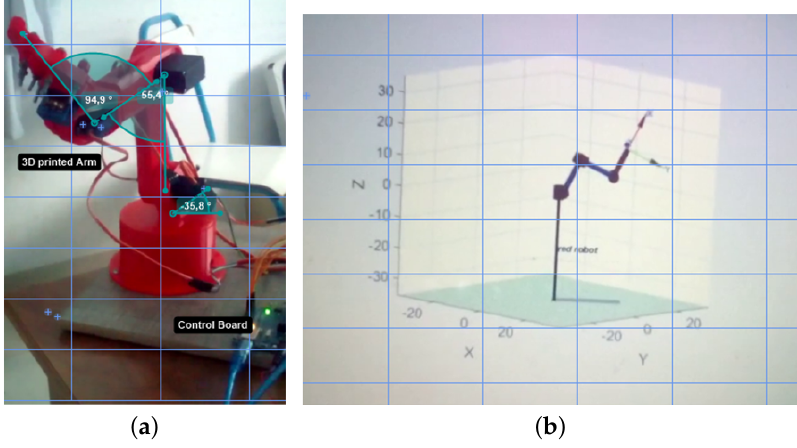
Figure 9. ( a ) 3D arm setup ( b ) Solution simulated in the control interface.